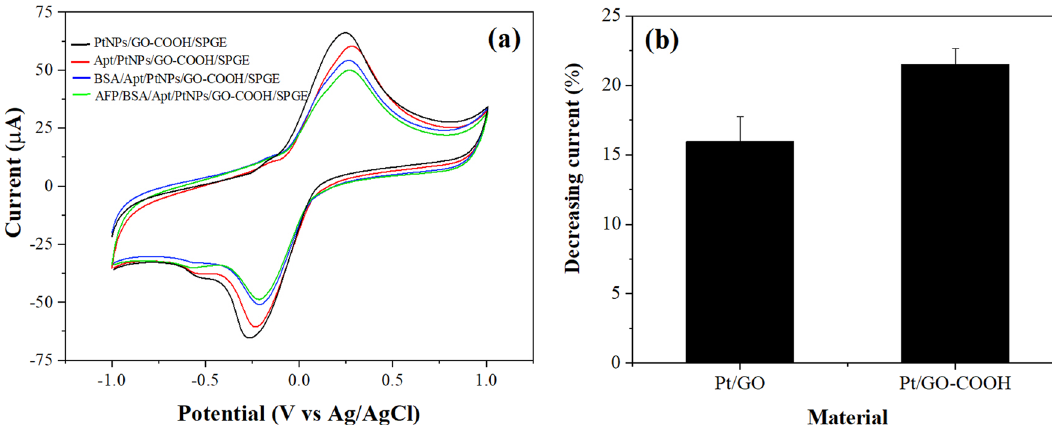
Figure 5. ( a ) CVs of the different modified electrodes in 10 mM PBS solution pH 7.4 containing 3 mM hydroquinone at a scan rate of 100 mV s −1 and ( b ) the current response of the BSA/Apt/PtNPs/GO/SPGE and the BSA/Apt/PtNPs/GO-COOH/SPGE to AFP 50 ng mL -1